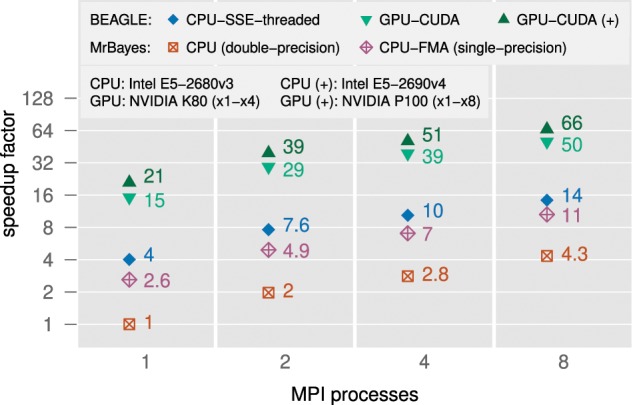
Relative performance gains (fold-speedup) for analysis with MrBayes v3.2.7 and BEAGLE v3.1.2, demonstrating the scalability across a range of MPI processes and hardware devices on nodes of the Comet Supercomputer available via CIPRES. Results denoted with a \documentclass[12pt]{minimal}
\usepackage{amsmath}
\usepackage{wasysym}
\usepackage{amsfonts}
\usepackage{amssymb}
\usepackage{amsbsy}
\usepackage{upgreek}
\usepackage{mathrsfs}
\setlength{\oddsidemargin}{-69pt}
\begin{document}
}{}$CDATA[$CDATA[$(+)$$\end{document} were benchmarked on nodes with a newer-specification CPU and GPU (the CPU executed non-BEAGLE code). As reference, we use the double-precision MrBayes calculator, running as a single CPU process. We use the same dengue virus data set as before (see Performance Evaluation section), with an increase in the number of Markov chains to four and replicate runs to two.